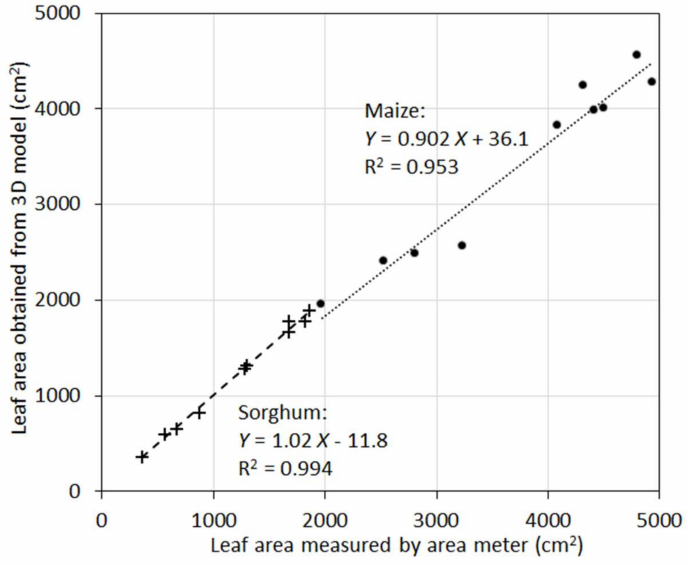
Figure 7. Scatterplot of total leaf areas of the 10 maize plants (circles) and 10 sorghum plants (crosses) measured by the leaf area meter vs. obtained from 3D plant